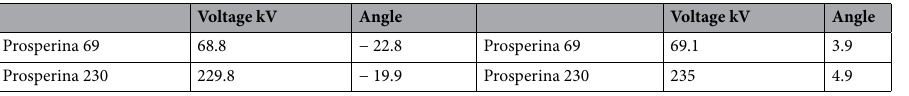
Table 8. Magnitude and angle variation before (left) and after (right) entering Nueva Prosperina static load model.